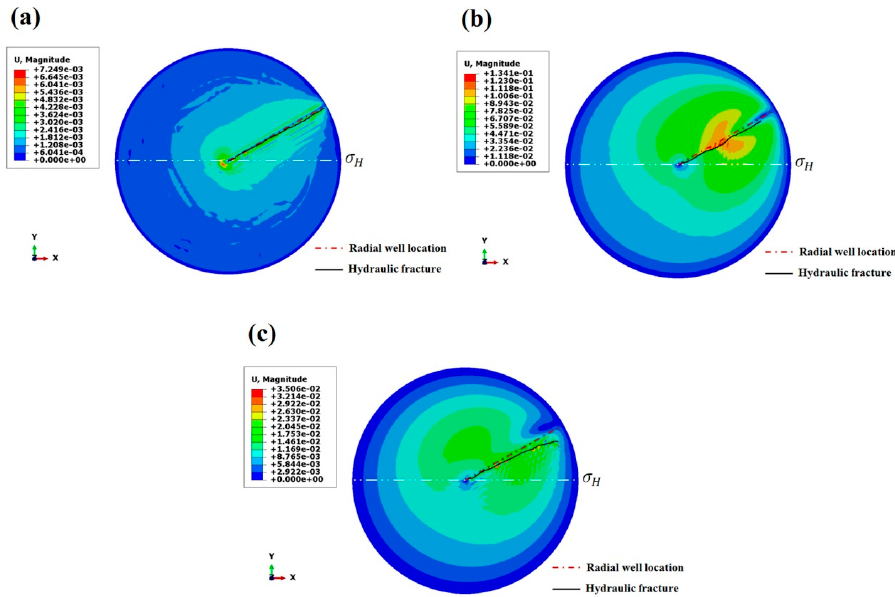
Figure 12. Simulation results of hydraulic fracture propagation guided by a single radial well under different reservoir permeabilities: ( a ) 1 × 10 − 3 μ m 2 ; ( b ) 10 × 10 − 3 μ m 2 ; and ( c ) 100 × 10 − 3 μ m 2 .